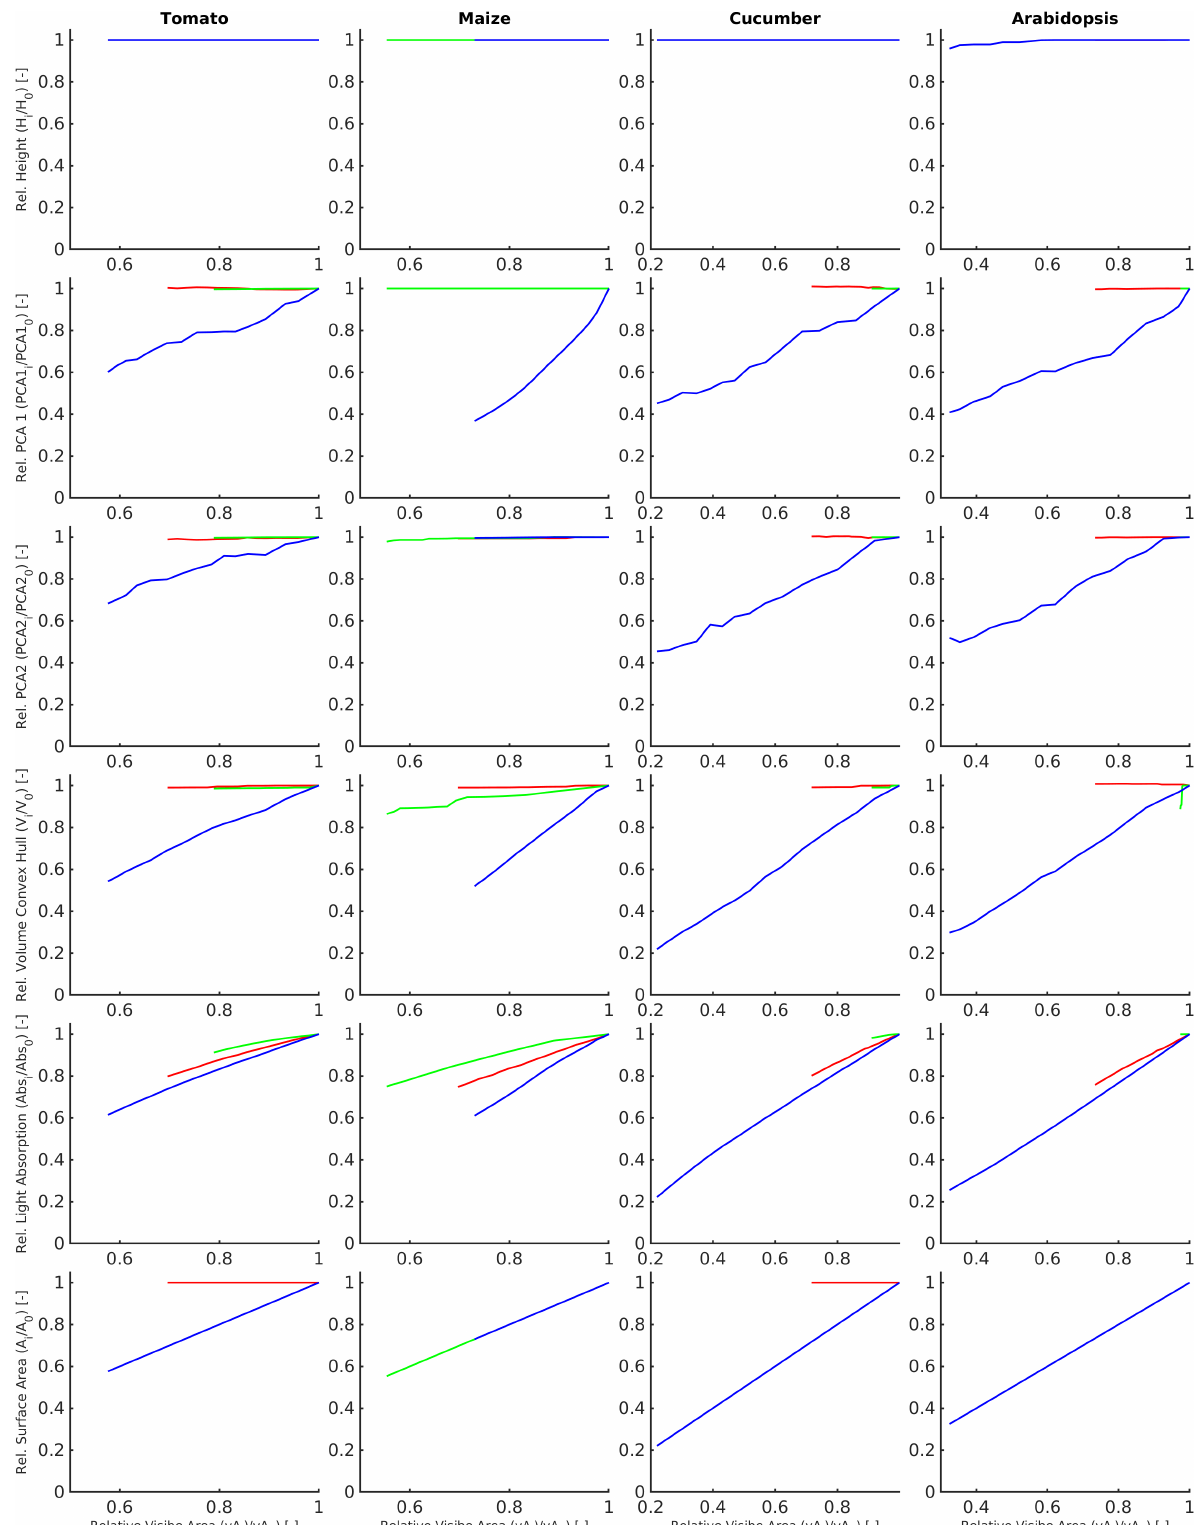
Figure 11. Visualization of the same phenotypic features as in Figure 9 but in dependency on the relative visible plant area shown in the last row of Figure